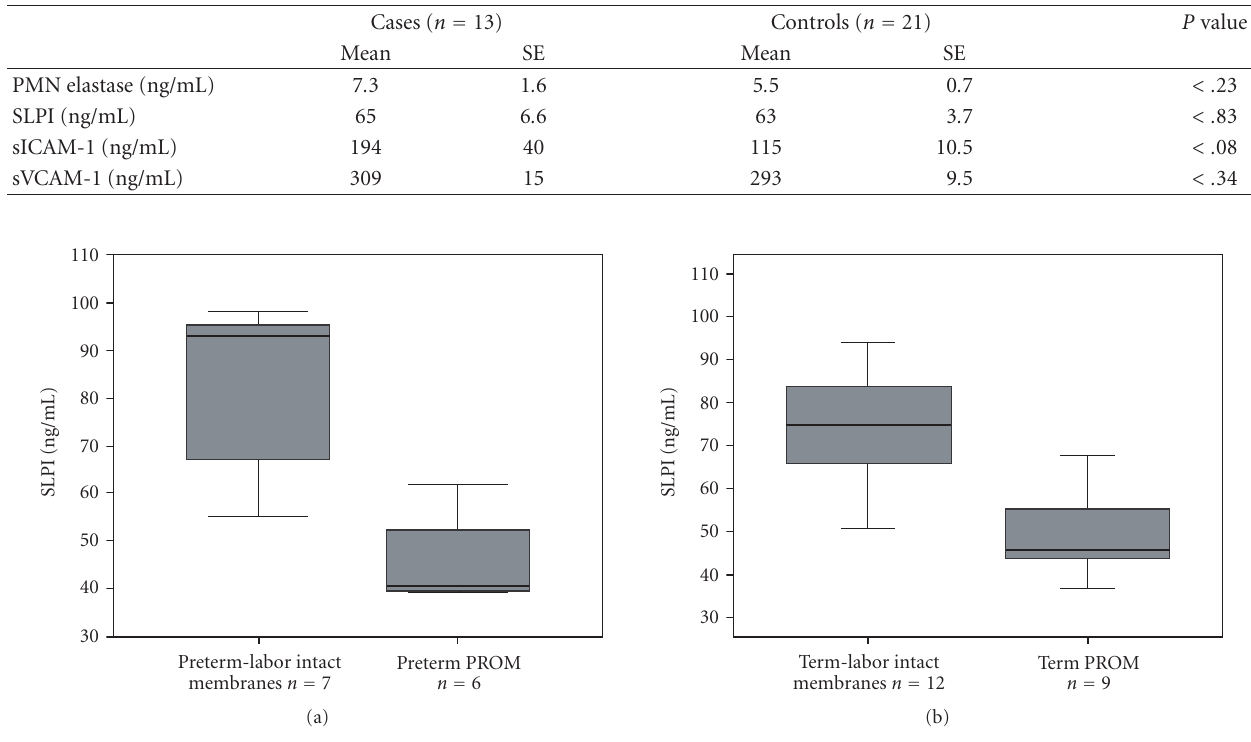
Table 2: Mean values and standard errors (SE) for each determined substance.